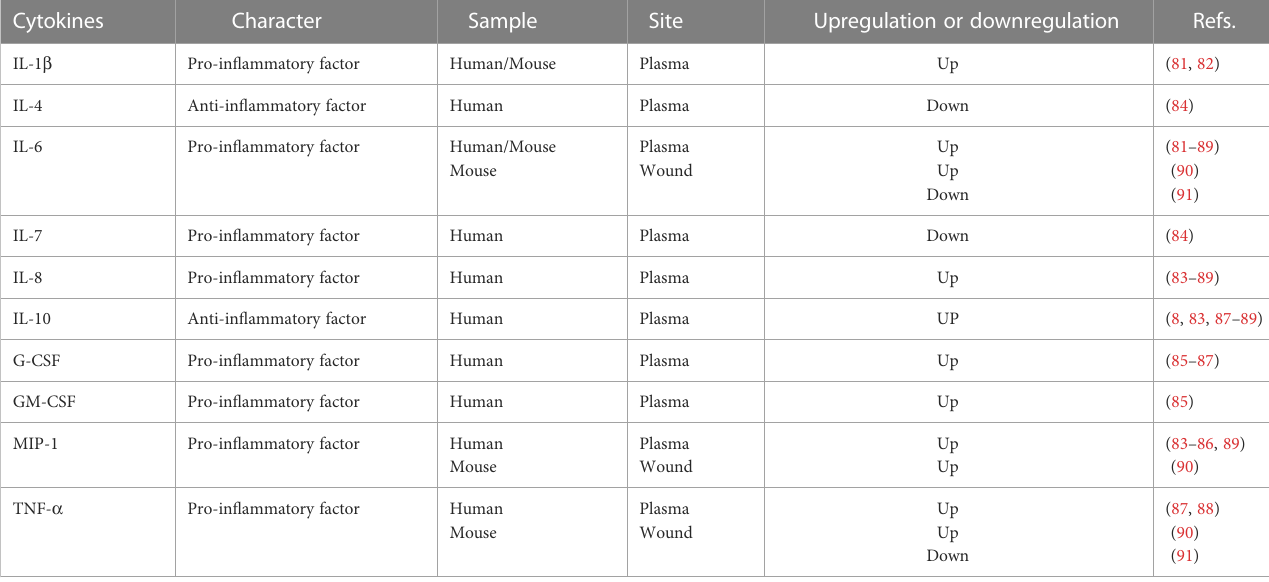
TABLE 2 In fl ammatory cytokine character and alteration in the burn